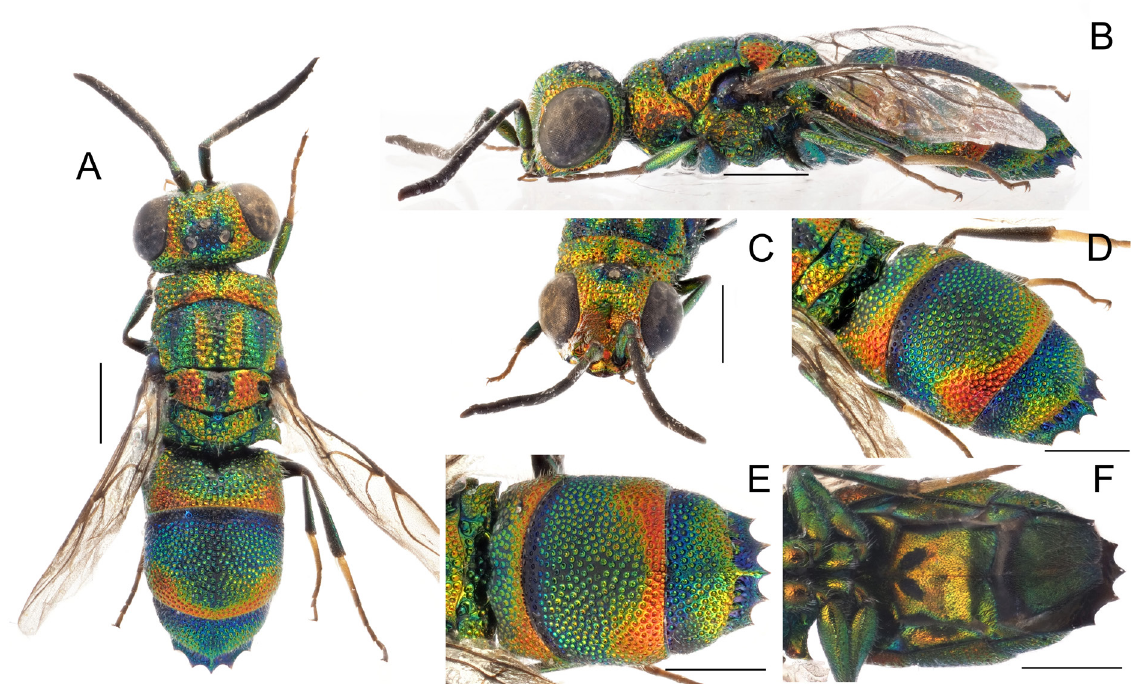
Fig. 2. Trichrysis inops (Gribodo, 1884), ♀, (NHME), Tamil Nadu. A . Habitus, dorsal view. B . Habitus, lateral view. C . Head, frontal view. D . Metasoma, postero-lateral view. E . Metasoma, dorsal view. F . Metasoma, ventral view. Scale bars: 1.0